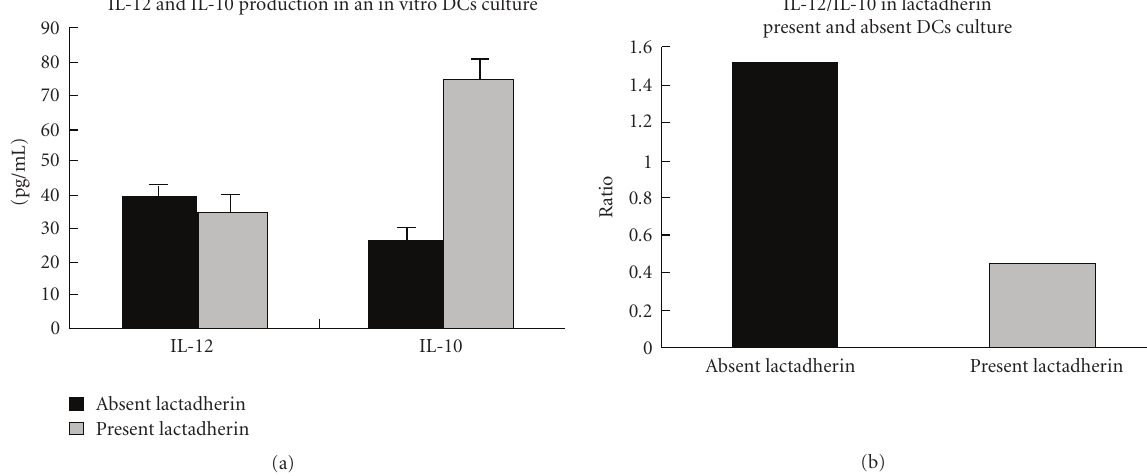
Figure 3: Levels of IL-12 and IL-10 production in lactadherin-present and -absent DC cultures (Means ± SD). No significant di ff erences in IL-12 production were observed with or without lactadherin present in the culture medium. However, IL-10 production was dramatically increased when lactadherin was present in the culture medium compared to when it was absent.